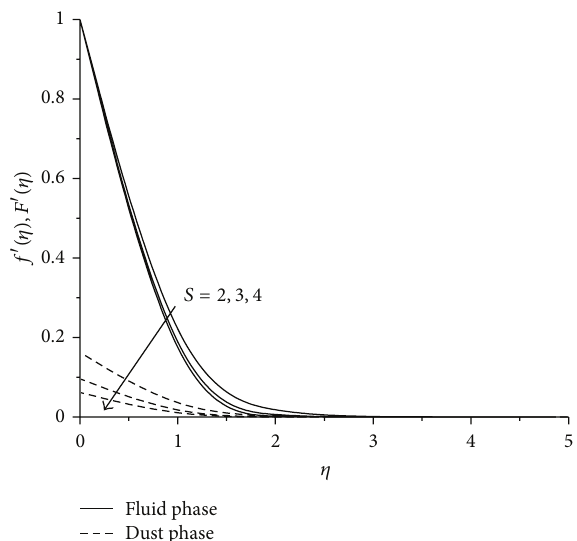
Figure 3: Effect of 𝑆 on velocity profiles with 𝑁 = 𝜆 = Ec = 0.5 , Pr = 0.72 , and 𝛽 = 0.6